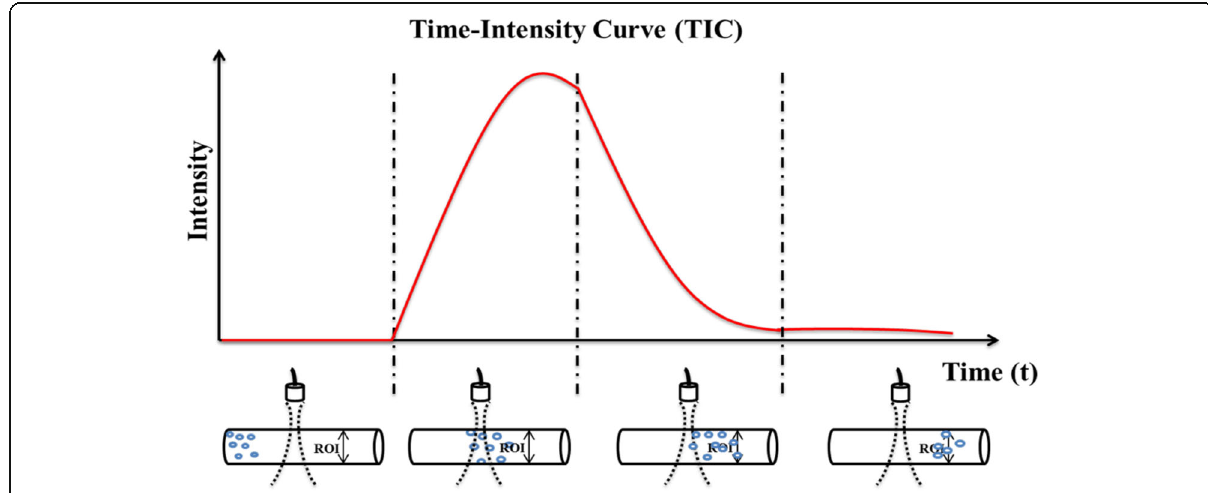
Fig. 3 Registration of the time-intensity curve. When the contrast has not reached the field of view of the transducer, the signal intensity is at baseline. Once the contrast in the vessels reaches the region being scanned, the transducer receives reflected waves caused by microbubbles and an increase in the signal is observed. As the contrast disappears, the signal intensity